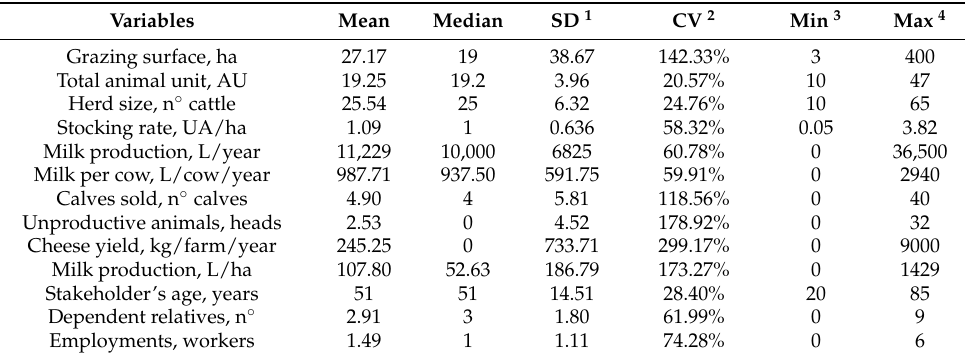
Table 1. Structural characteristics of dual-purpose farms ( n =